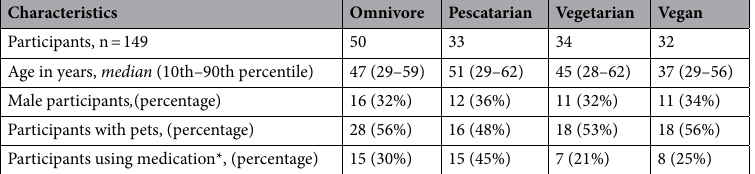
Table 1. Study participants characteristics included in metagenomic shotgun sequencing. *Medication other than antibiotics, proton pump inhibitors, insulin and cancer